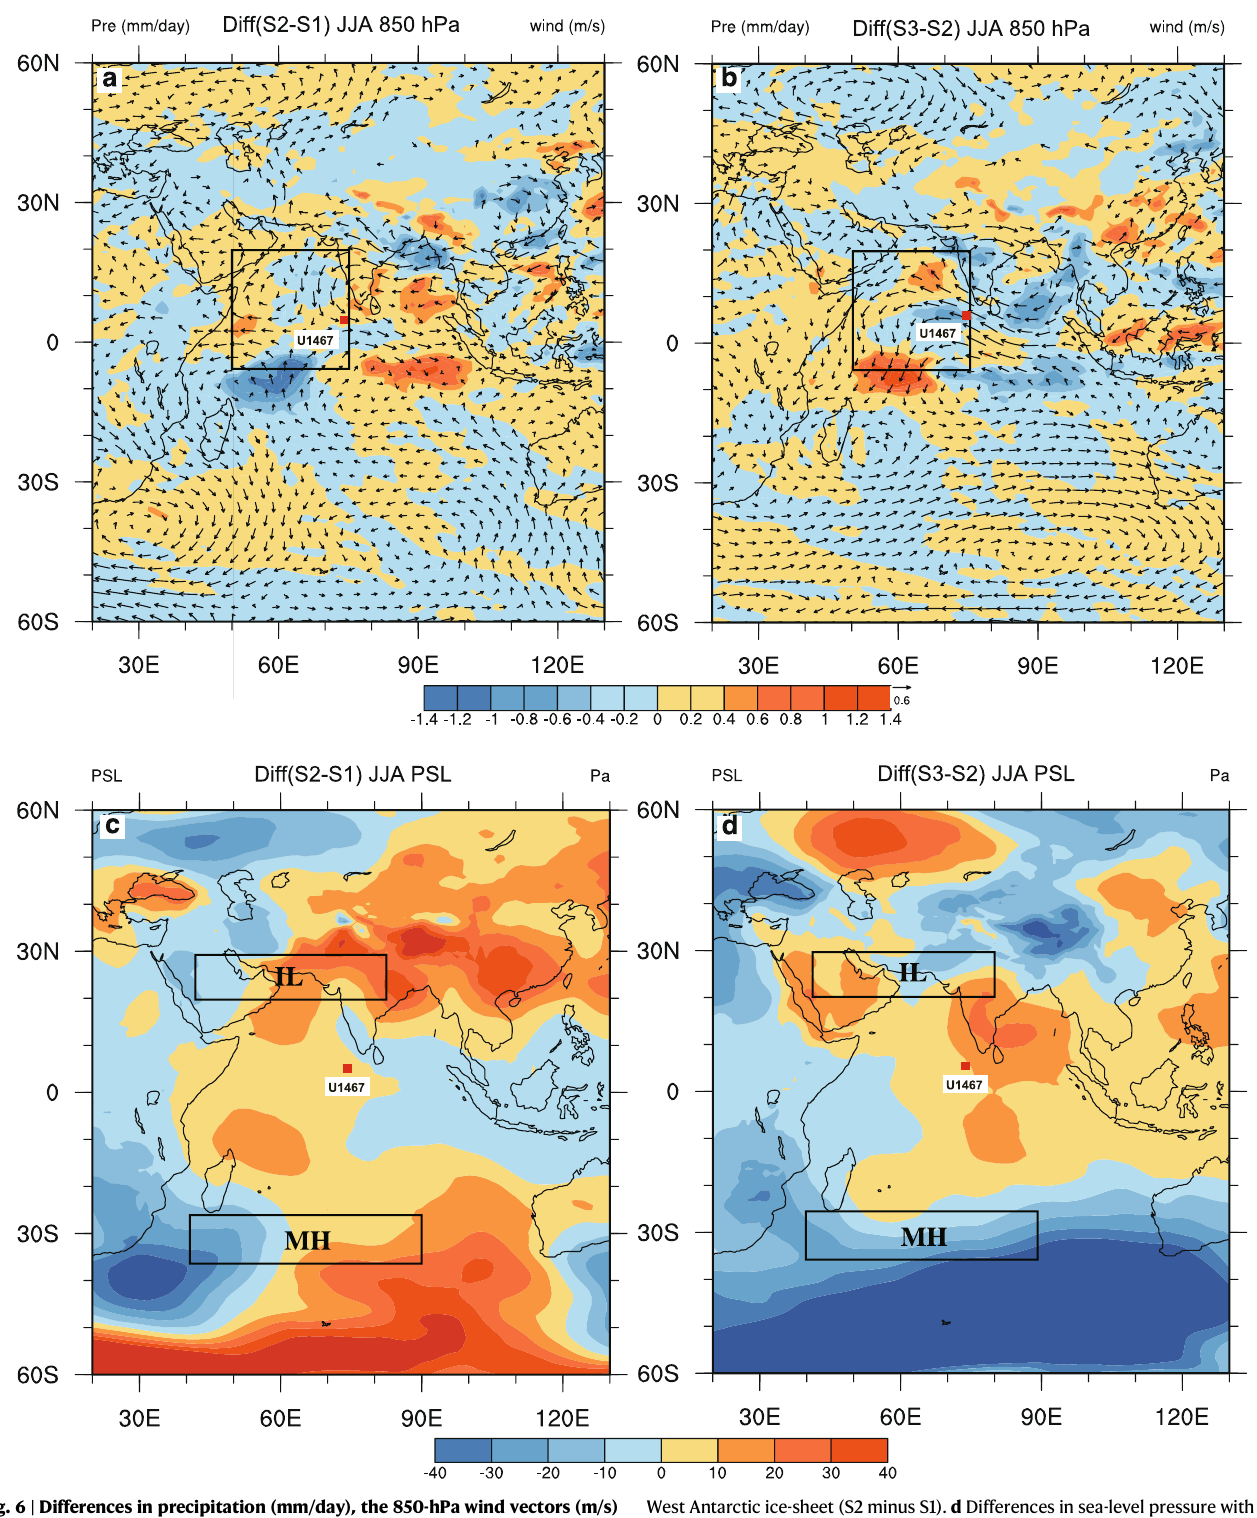
West Antarctic ice-sheet (S2 minus S1). d Differences in sea-level pressure with the expansionoftheGreenlandicesheet(S3minusS2).Therectangledenotesthearea (50° – 75°E, 5°S – 20°N) selected for calculating the precipitation and the 850-hPa windspeedinFig.5a.TheMascareneHigh(MH;40° – 90°E,25° – 35°S)andtheIndian Low (IL; 40° – 80°E, 20° – 30°N) are indicated and labeled. The red square refers to Site U1467.